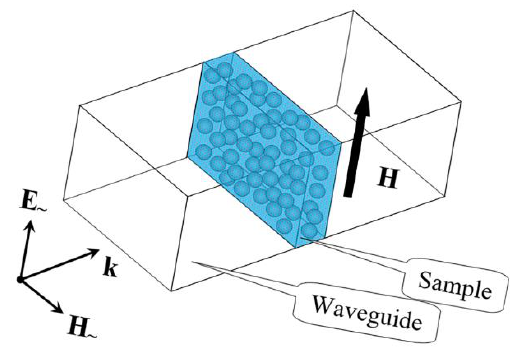
Figure 4. Scheme of microwave measurements.